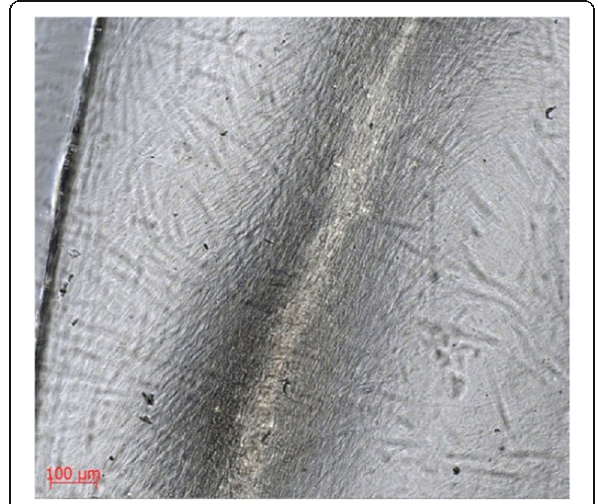
Fig. 2 Human osteoblasts forming a bony spicule on tantalum- coated glass